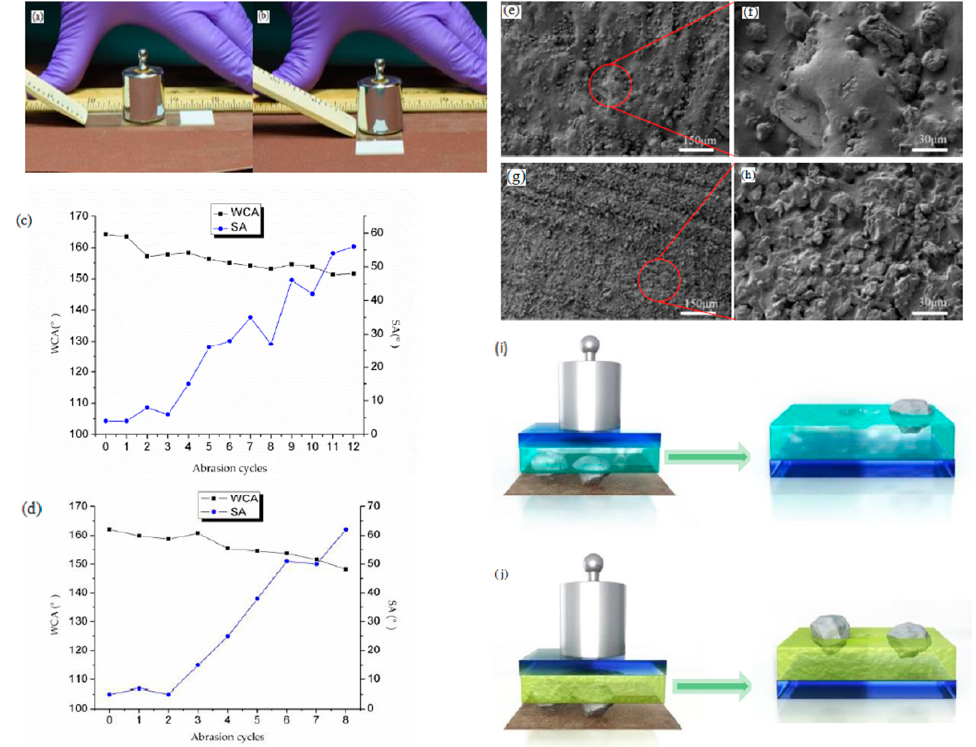
Figure 5. ( a , b ) Demonstration of one abrasion cycle; changes curves of WCA and SA of ( c ) the D coating and ( d ) the E coating during abrasion; surface status of ( e , f ) the D coating after 12 abrasion cycles and ( g , h ) the E coating after eight abrasion cycles; illustration of the L-CNC particles before and after abrasion in the ( i ) E coating and ( j ) the D coating.